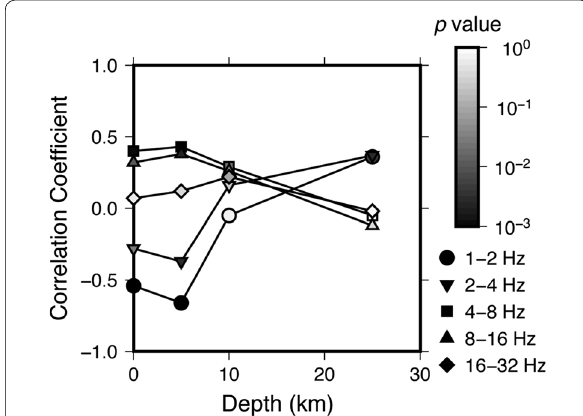
Fig. 9 Plots of depth versus the correlation coefficient between the coda Q and the S-wave velocity (Nakajima and Hasegawa 2007). The p value is represented by the